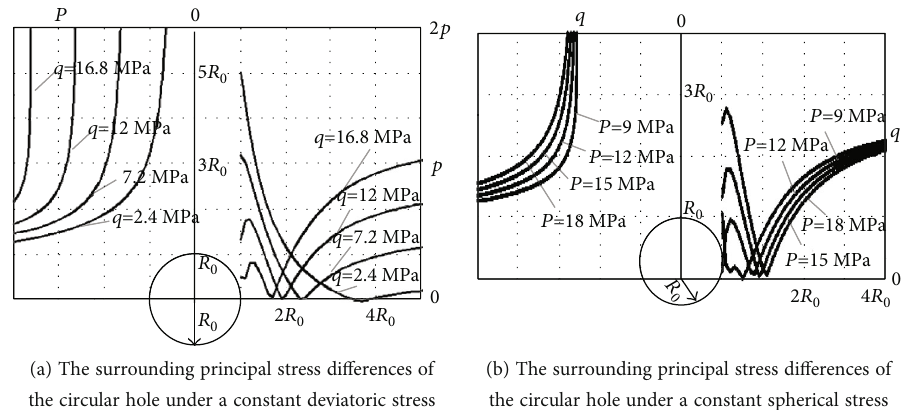
Figure 2: The distribution of principal stress di ff erence around circular hole. Table 1: The rock mass mechanical